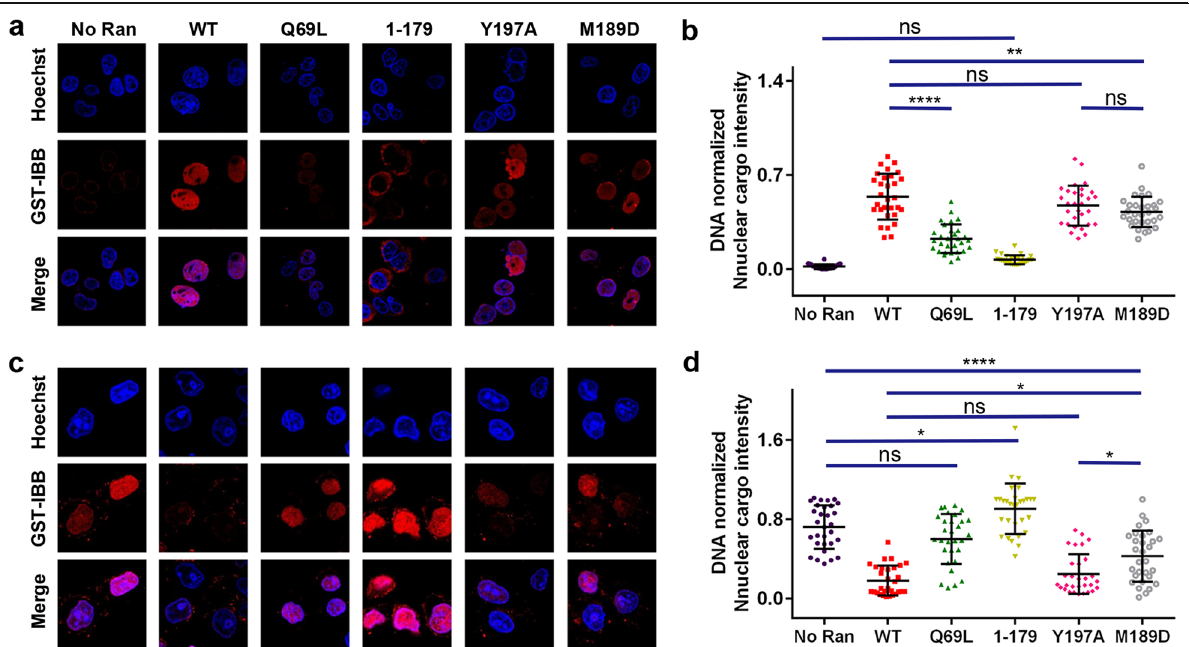
Fig. 4 Slightly reduced efficiency in nuclear import and export by C-dis mutants in semi-permeabilized HeLa cells. a HeLa cells after nuclear import of GST-cargoes in the presence of Ran or different mutants were stained with anti-GST antibody (red). The GST-tagged importin β 1 binding domain of importin α 1 (GST-IBB) was used as the nuclear import cargo. For unknown reason, Ran 1 – 179 is more prone to cytoplasmic staining, which theoretically should not be seen in semi-permeabilized cells. b Quantification and statistical analysis of nuclear import shown in panel ( a ). The level of nuclear import is assessed by nuclear cargo intensity (normalized with DNA intensity). **** p < 0.0001; ** p < 0.01; * p < 0.05. c HeLa cells after nuclear export of GST-cargoes in the presence of Ran and different mutants were stained with anti-GST antibody (red). GST- tagged human RanBP1 (GST-hRanBP1, which contains an NES) were used as the nuclear export cargo. d Quantification and statistical analysis of nuclear import shown in panel ( c